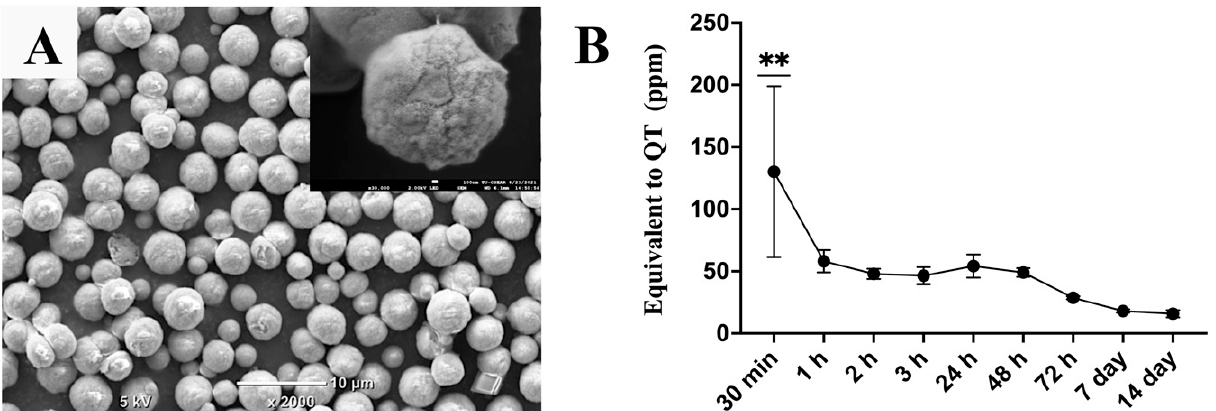
Figure 1. ( A ) Scanning electron microscopy image of the QT-incorporated calcium carbonate micro- capsules. ( B ) Total flavonoid-content assay demonstrating a release profile of QT from the micro- capsules incubated in phosphate buffer saline at 37 °C for 14 days; magnification bars represent 10 µm. The symbol ** denotes that the value is significantly higher than at other investigation times, with p < 0.01 (n = 5, mean ± SD).